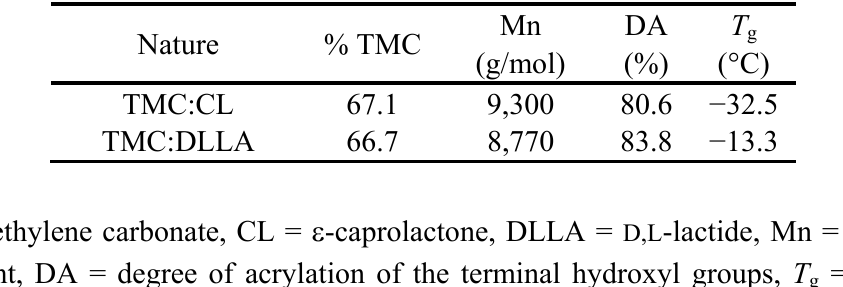
Table 1. Chemical properties of the acrylated star-copolymer prepolymers.